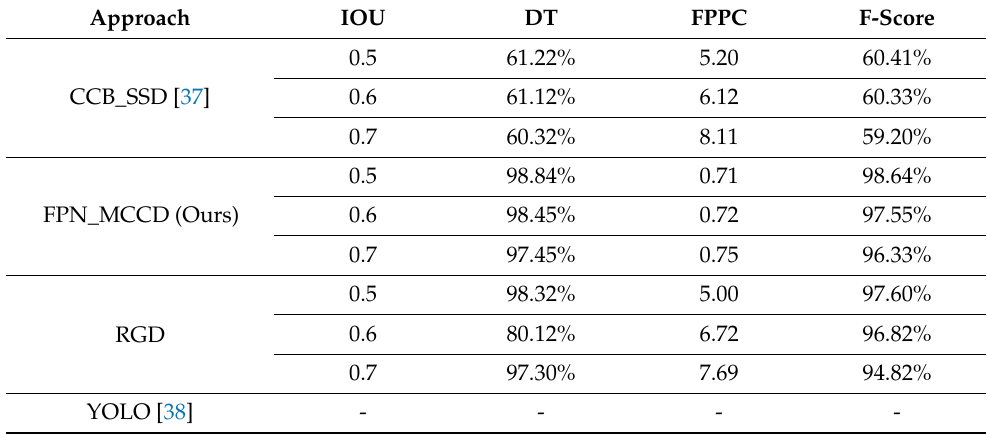
Figure 6. Samples of the KNU dataset used in our experiments with some information that provides the name and the number of images-obtained for each group. Table 1. Comparison between FAN_MCCD and SSD with different values of IOUs in terms of detection rate (DT), false positive per character (FPPC), and